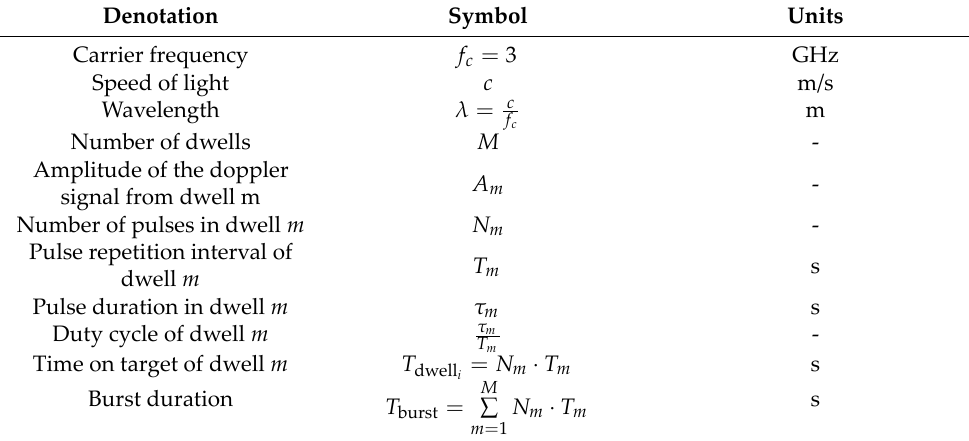
Table 1. Waveform characteristics.